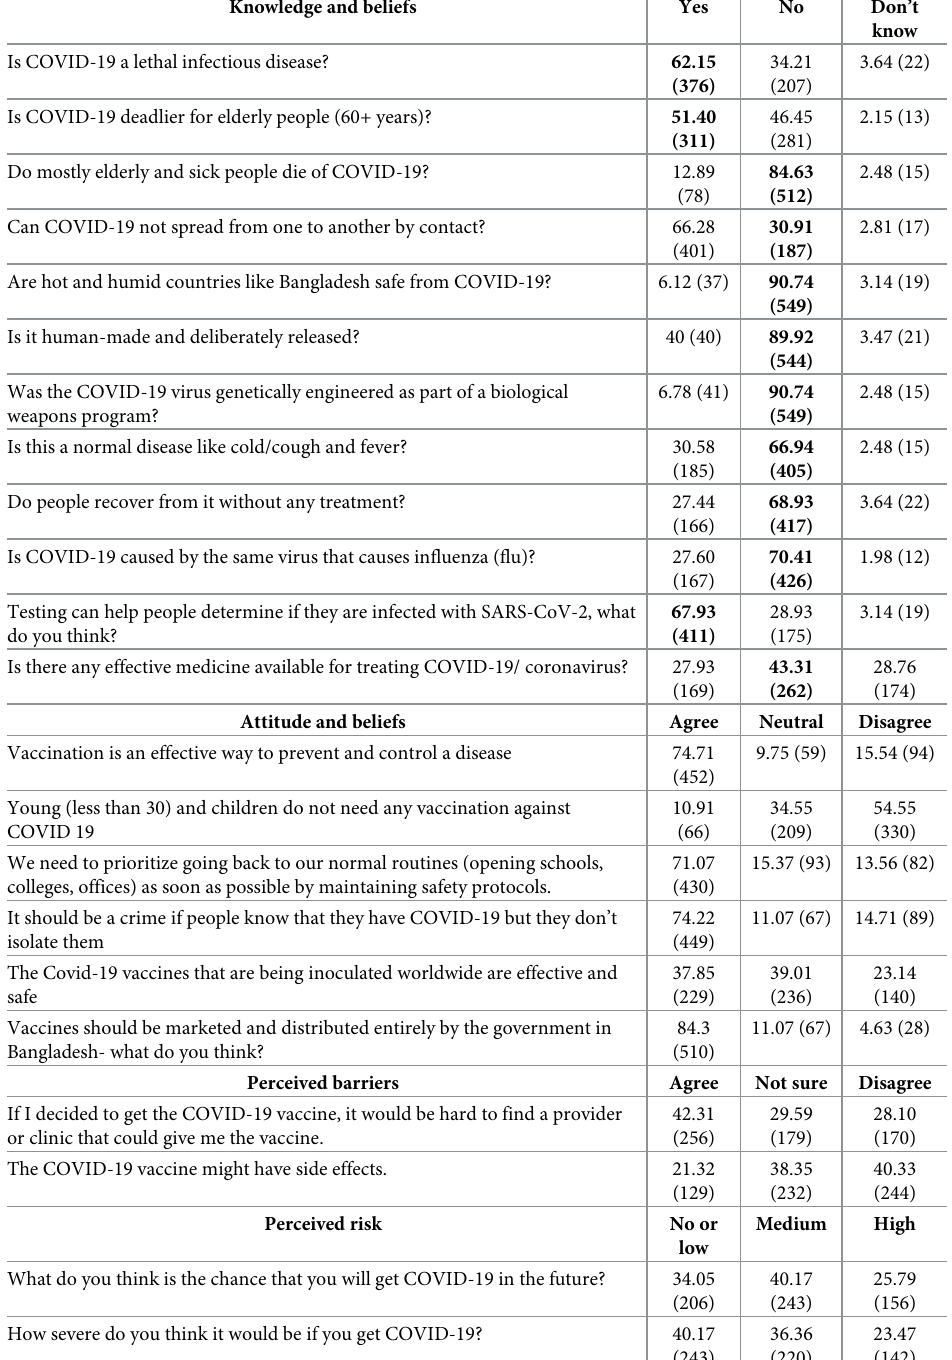
Table 2. Descriptive statistics for items measuring knowledge, beliefs, and attitudes about COVID-19, COVID-19 vaccination (n = 605). Knowledge and